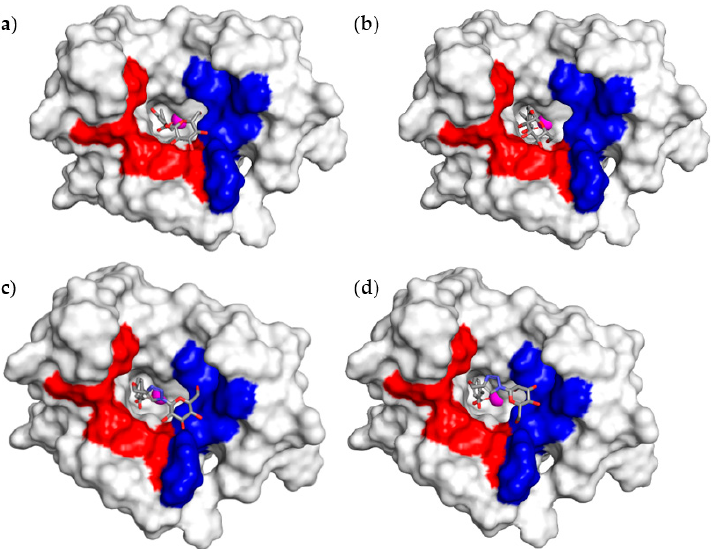
Figure 4. The modes of action for compounds 8 ( a ), 9 ( b ), 10a ( c ), 10c ( d ), in the active site of hCA IX. The hydrophilic and hydrophobic region of active site were displayed with blue and red background, respectively.